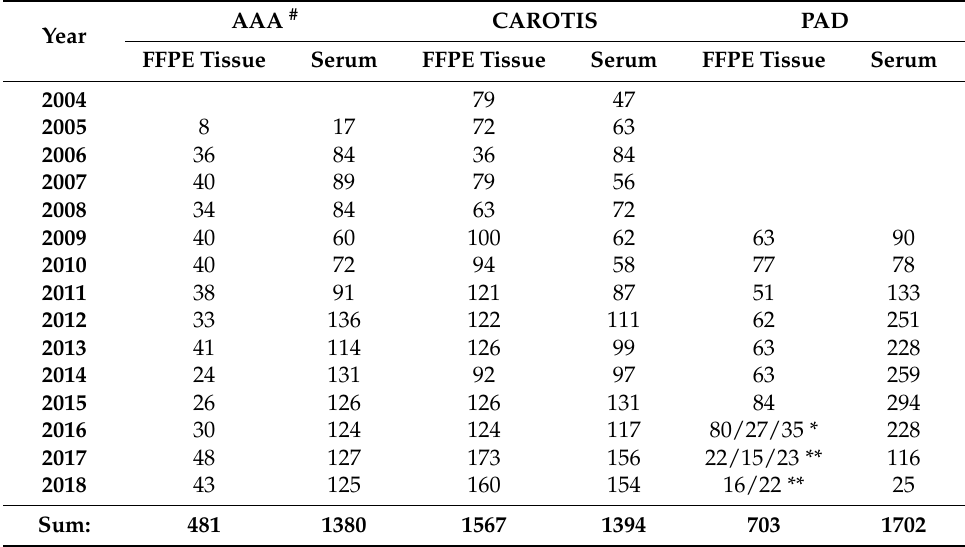
Table 1. Munich Vascular Biobank. List of samples collected over the years.